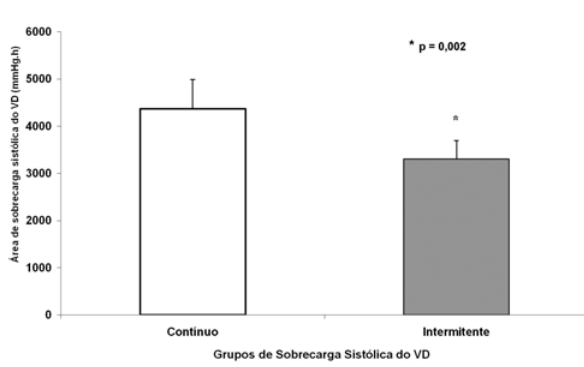
Fig. 2 - Diagrama da área de sobrecarga sistólica do Ventrículo Direito (VD). Área de sobrecarga dos grupos submetidos à bandagem contínua versus intermitente do Tronco Pulmonar (TP). (* p =